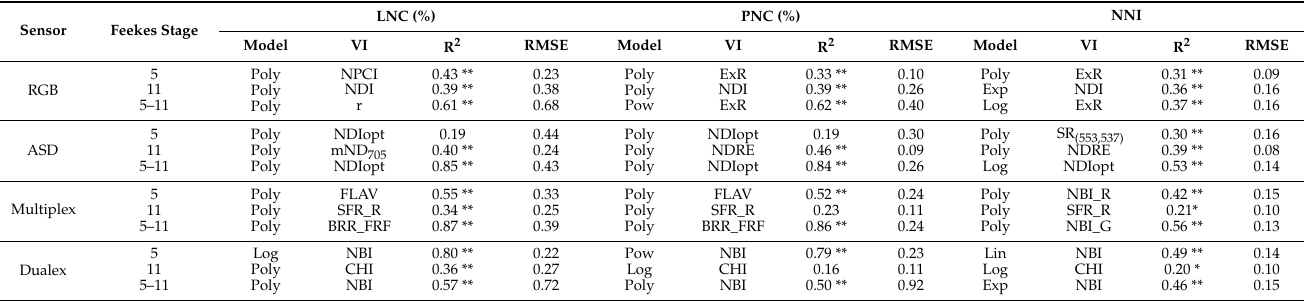
Table 7. Relationship between wheat N variables and VIs from different sensors at different growth stages (n =